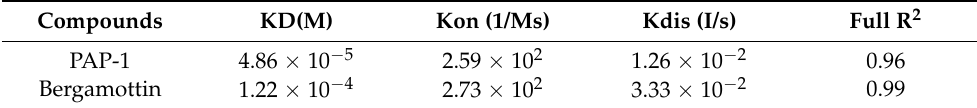
Table 3. The interaction between compounds and RBD Spike S proteins.